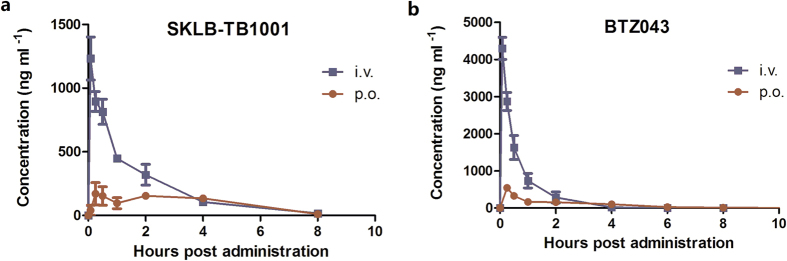
Pharmacokinetic analysis of SKLB-TB1001 in SD rats.Mean plasma concentration-time curves of (a) SKLB-TB1001 and (b) BTZ043 following a single 5 mg/kg dose administered by oral gavage (p.o.) or intravenous injection (i.v.) in SD rats. Data are presented as means ± SD (n = 3).